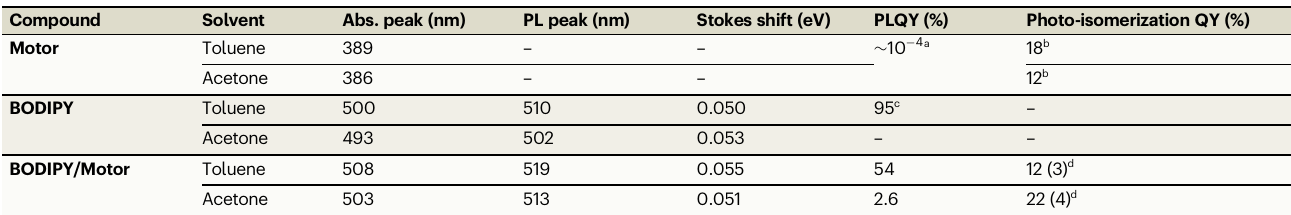
Table 1 | Summary of absorption and PL peaks, Stokes shifts, PL and photoisomerization quantum yields (QYs) Compound